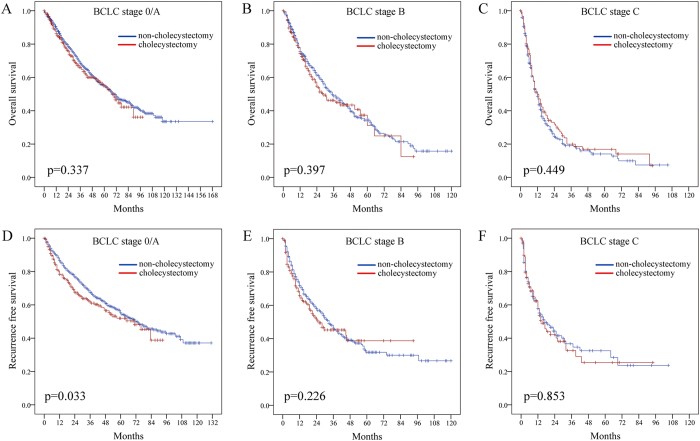
(A–C) Comparison of cumulative incidence of OS according to BCLC stage between cholecystectomy group and non-cholecystectomy group; (D–F) Comparison of cumulative incidence of RFS according to BCLC stage between cholecystectomy group and non-cholecystectomy group.